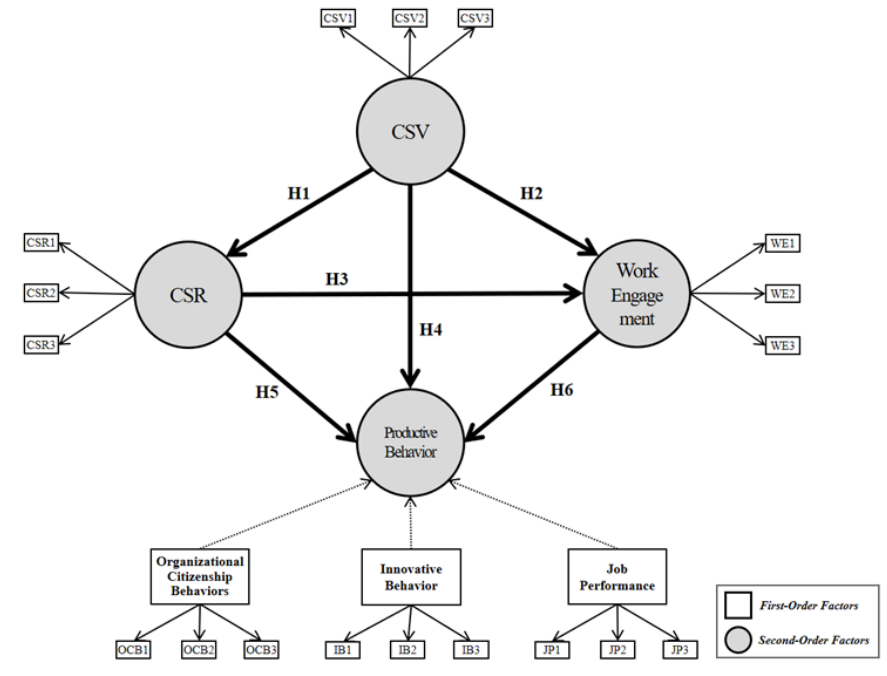
Figure 2. Research model.